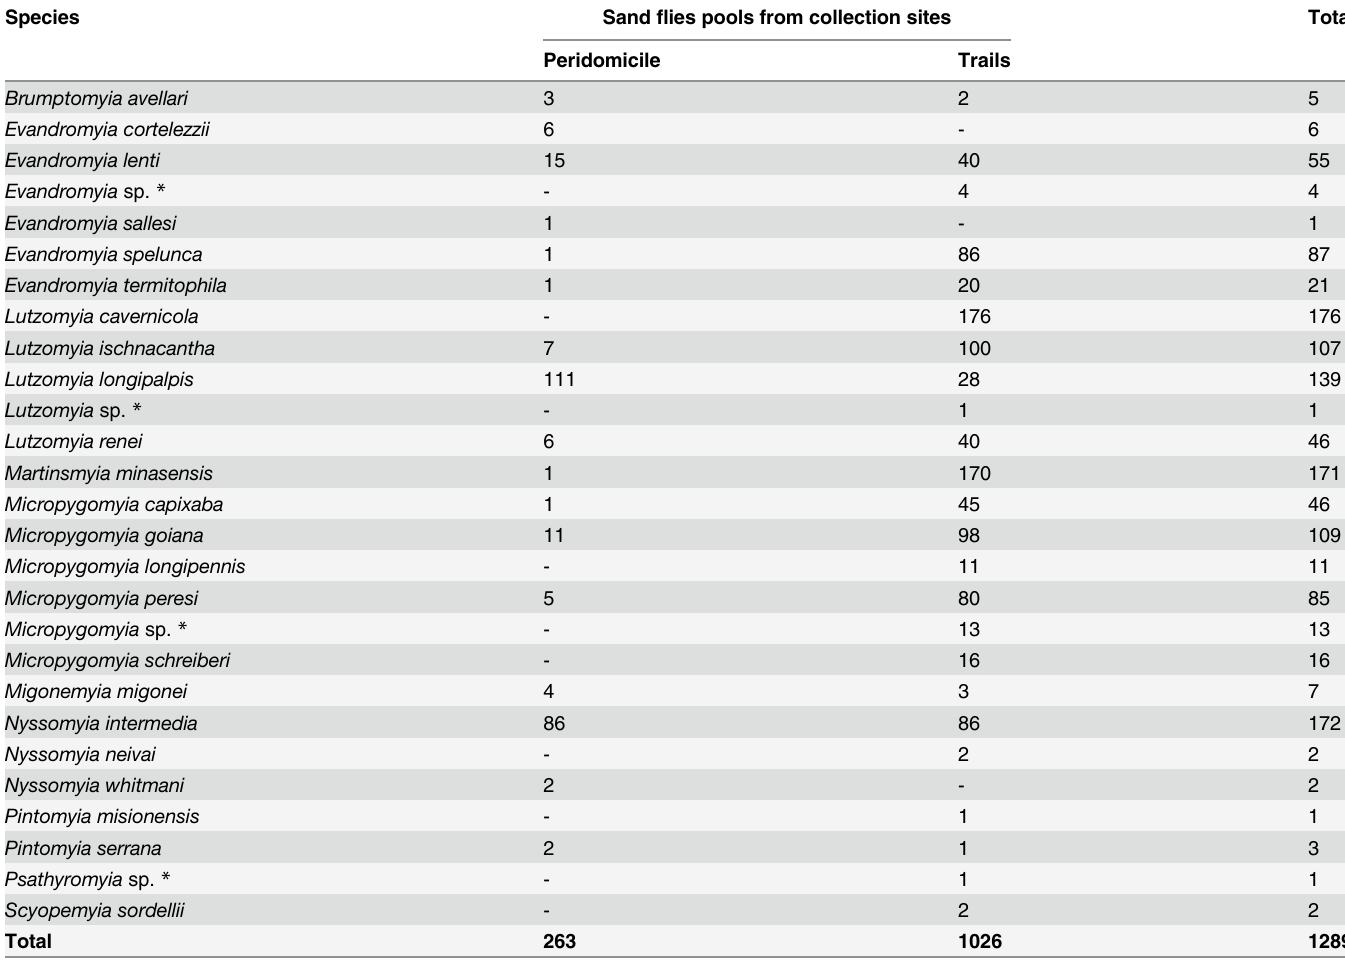
Table 2. Sand flies collected and grouped in pools of up to ten specimens according to collection site within the Xakriabá Indigenous Reserve,